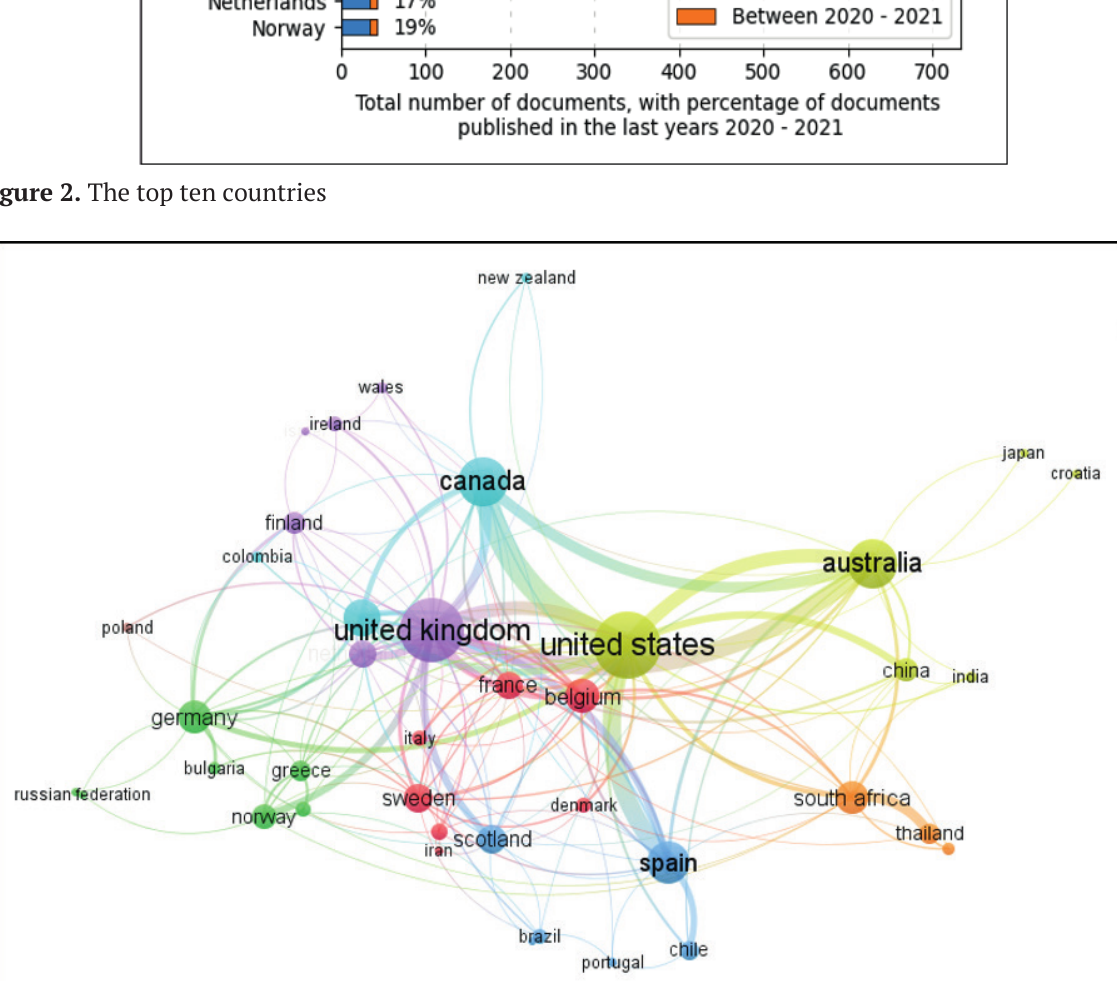
Figure 3. Total link strength co-authorship base on